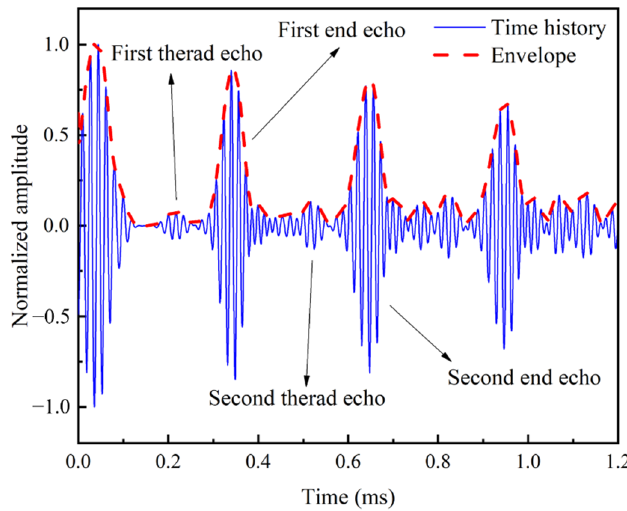
Figure 24. Filtered echo signal at initial baseline state.